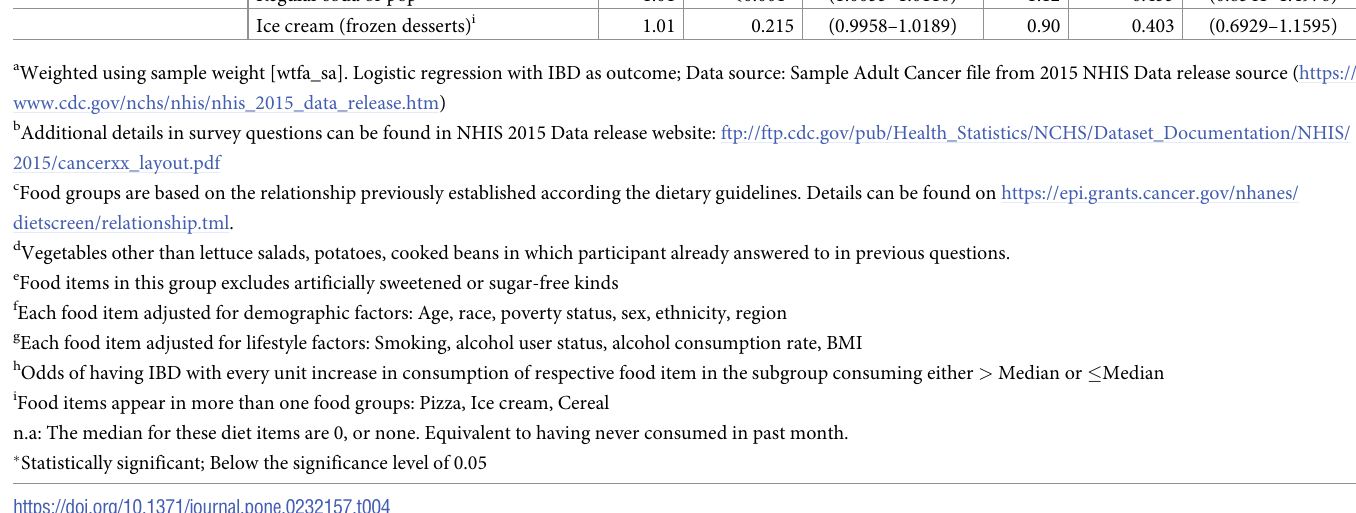
Weighted, Adjusted for Demography and